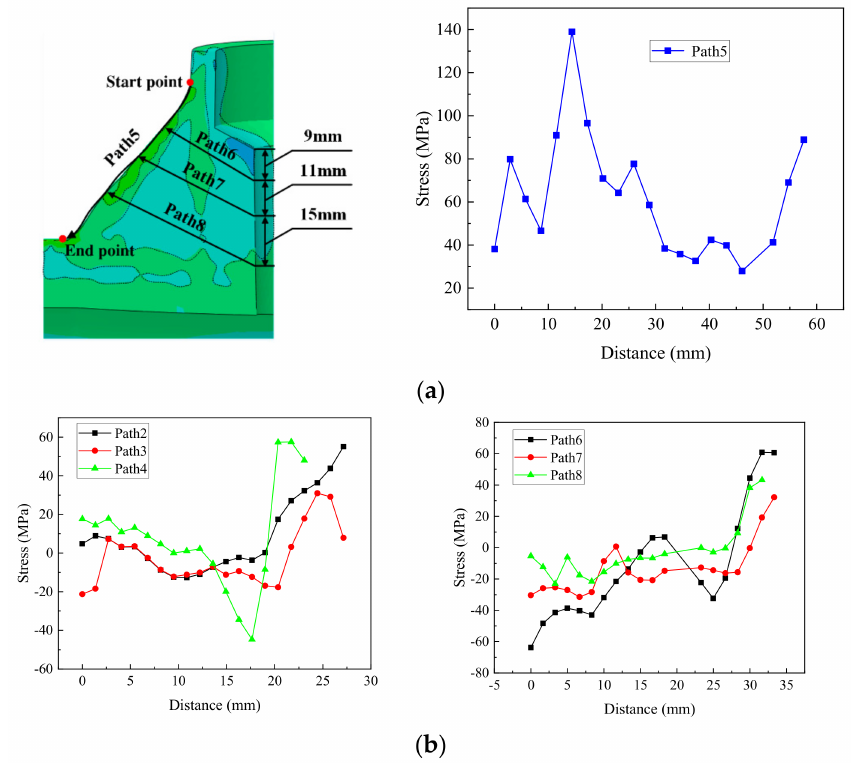
Figure 8. Residual stress along different paths: ( a ) stress distribution along Path1 and Path5; ( b ) stress distribution along Path2 to Path4 and Path6 to